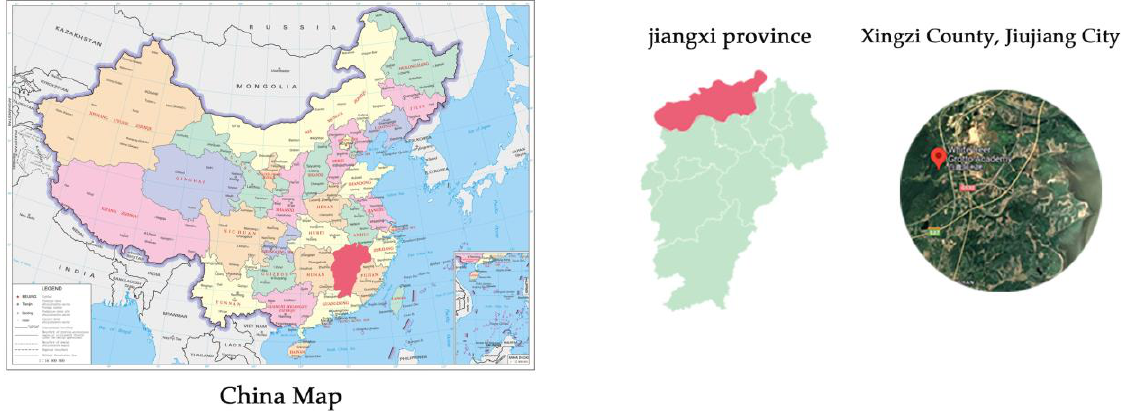
Figure 2. Location map of the Bailudong Academy complex (Source: China National Geospatial Information Platform).